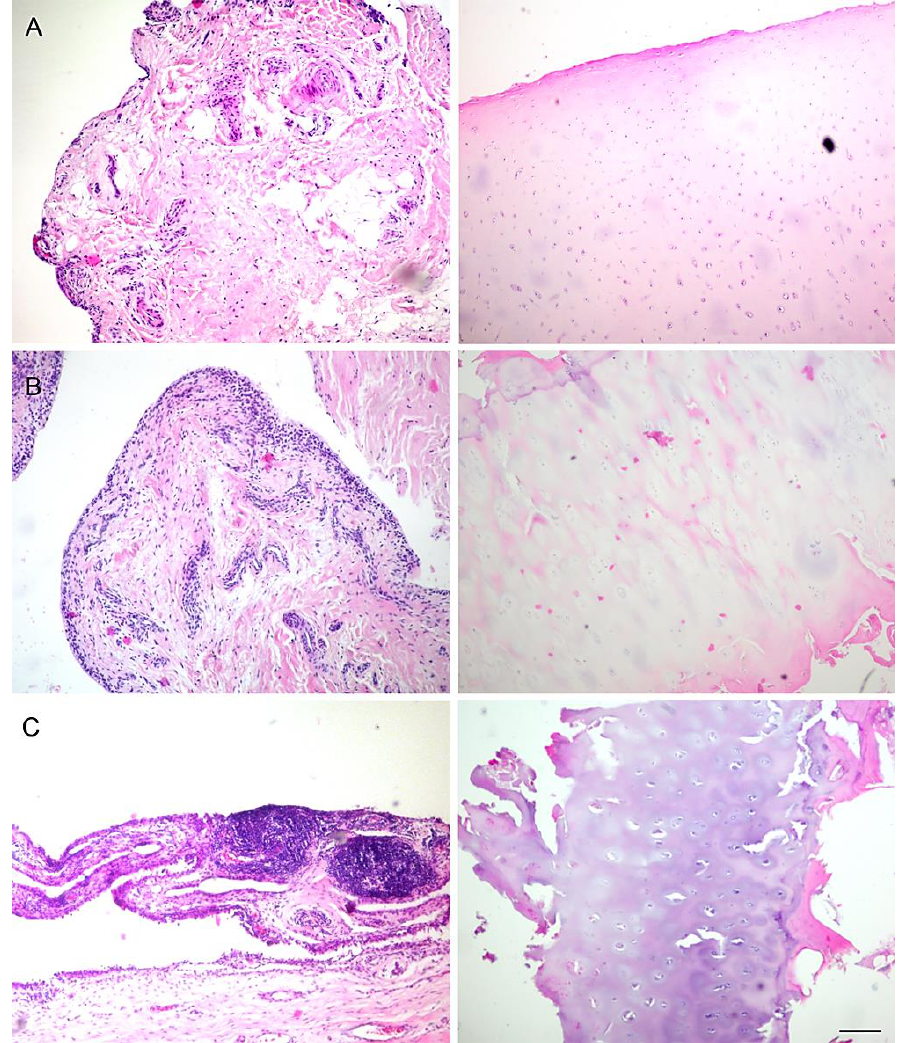
Figure 2. Synovial membrane (first column) and cartilage (second column) of control patients ( A ), and patients with moderate ( B ) and severe ( C ) hip osteoarthritis (HOA). Hematoxylin and Eosin staining. Magnification ×40, scale bar = 40 µm.